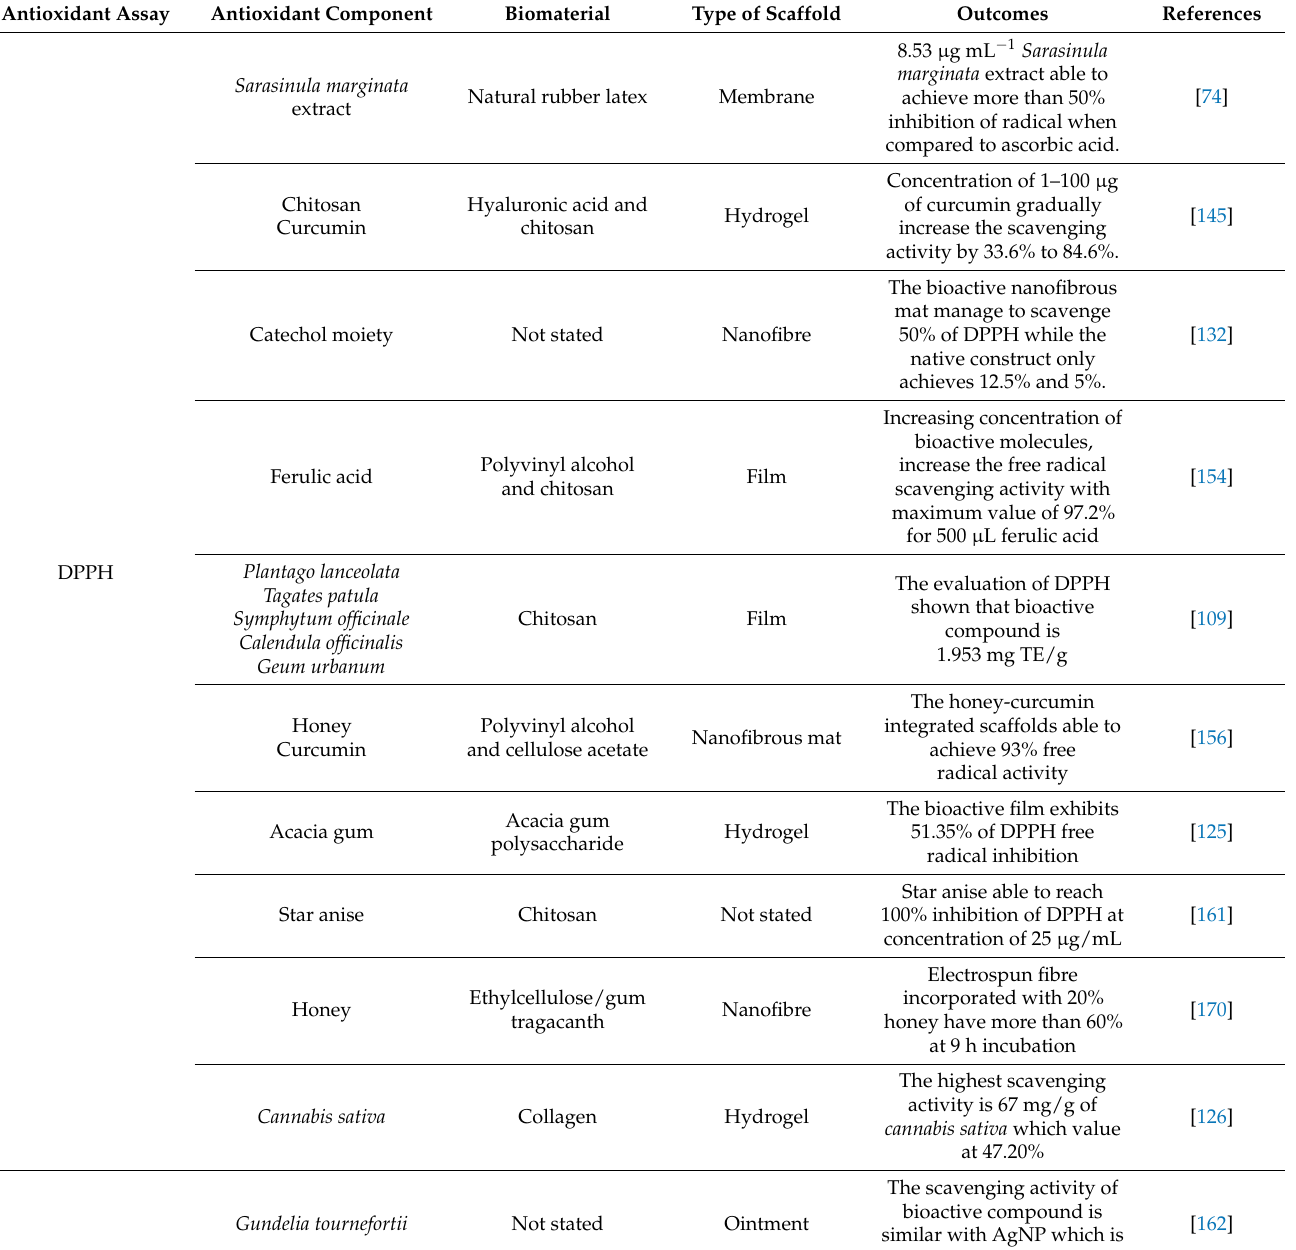
Figure 5. Control release antioxidant compounds from biomaterials. The idea of the figure is adapted from [169]. Table 3. The antioxidant assays of the biomaterials for wound healing